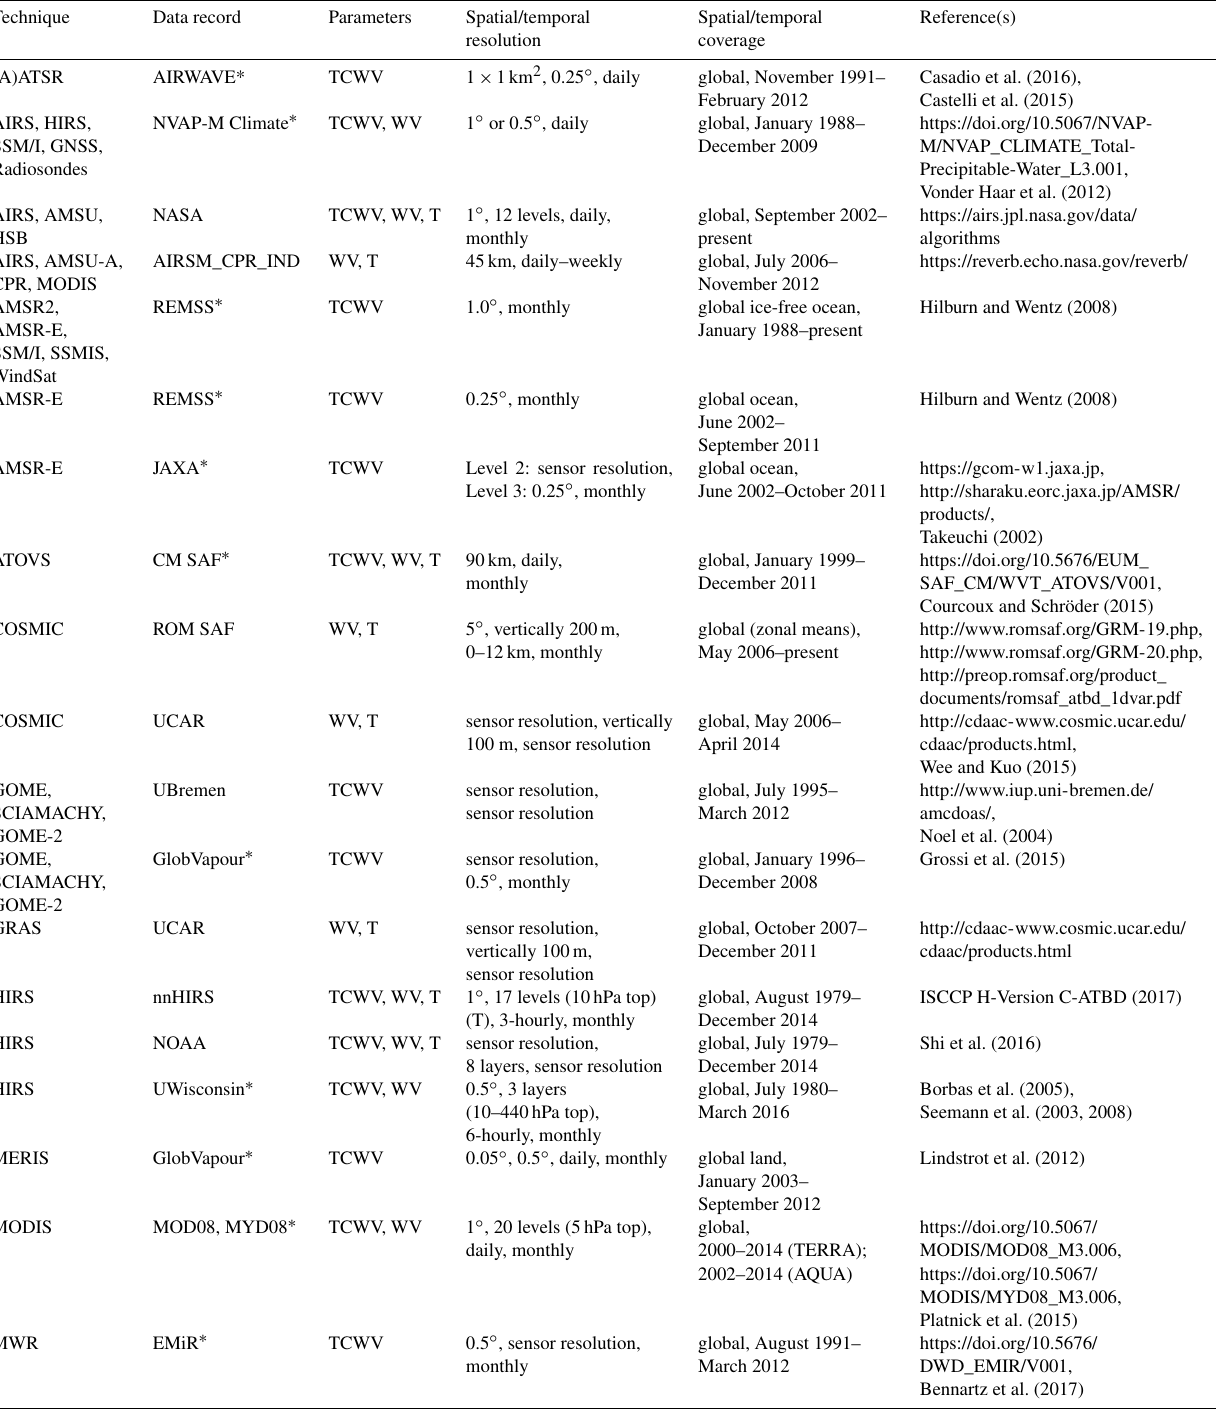
Table 2. Satellite and reanalysis data records. Typically the data record name is given under “Data record”. If not available the owner’s name is provided. Last access to all webpages mentioned in this table: 12 June